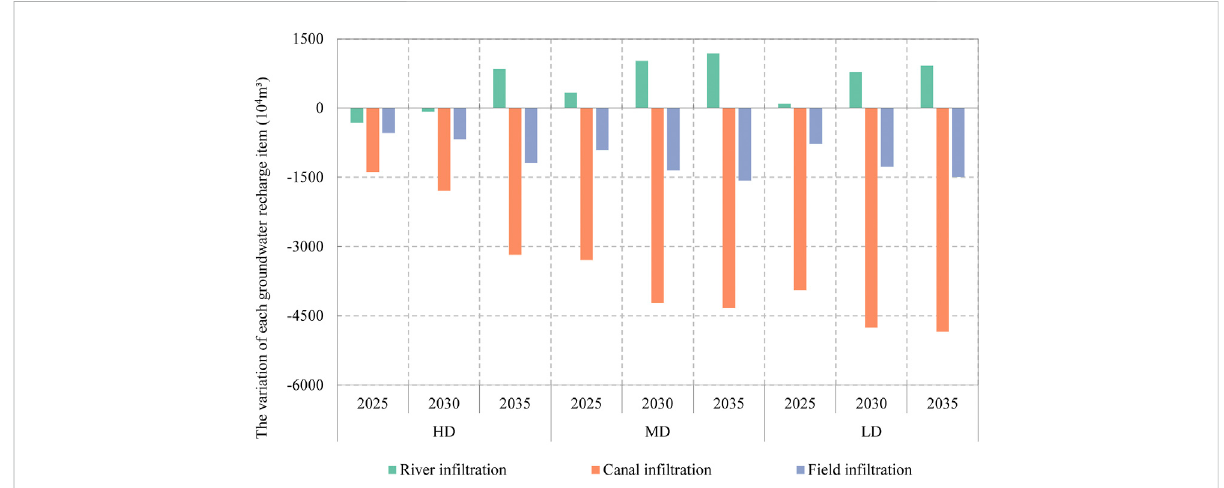
FIGURE 5 Variation of groundwater recharge from different sources.